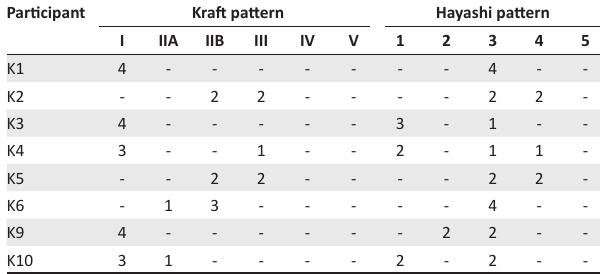
TABLE 4: Kraft and Hayashi pattern frequencies on eight participants over four visits per person after imputation.